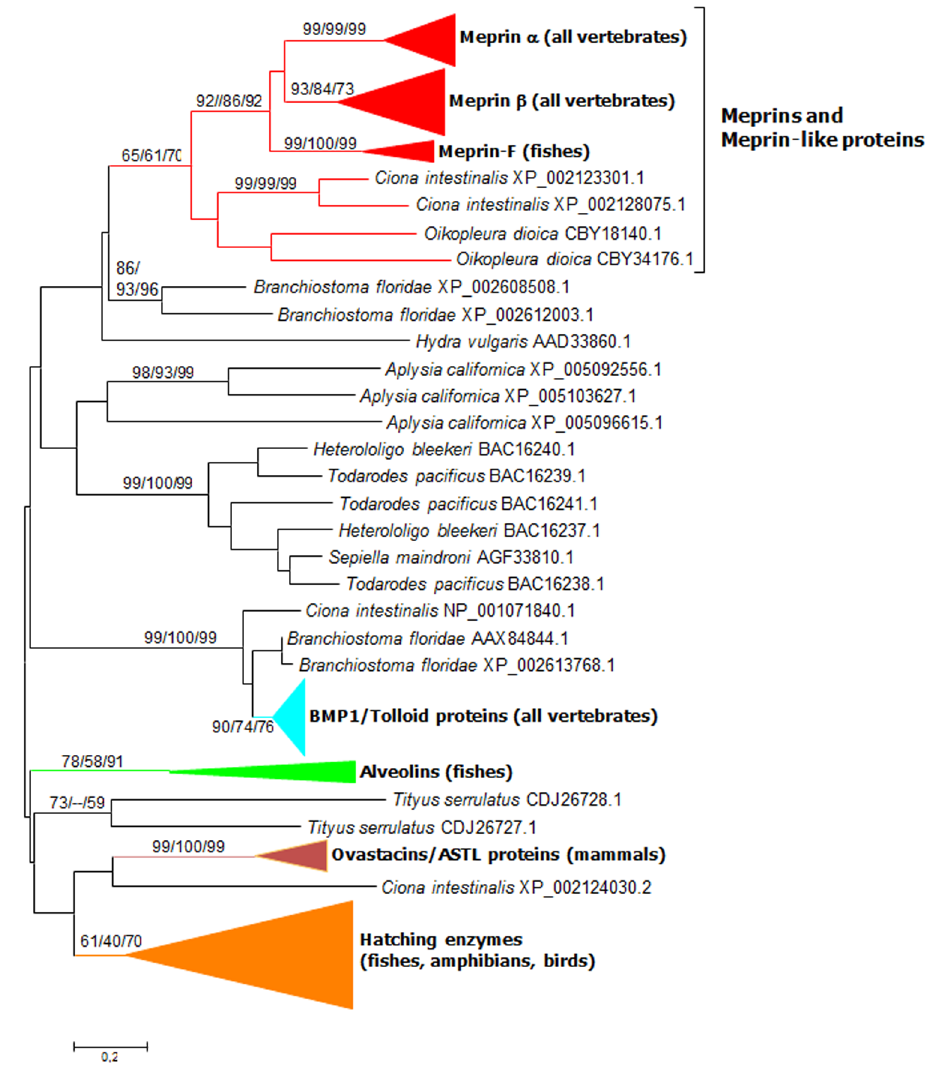
Fig 3. Analyses of selected protease sequences. Numbers indicate NJ/MP/ML bootstrap support, in percentages (1000 replicates for the NJ analysis; 100 for the MP and ML analyses). The ML tree was obtained using the Jones-Taylor-Thornton (JTT) with frequencies model of amino acidic substitutions, using again a G distribution and assuming some invariable sites (JTT + G + I + F model), which was selected as the most accurate in this case. MP analyses used the TBR